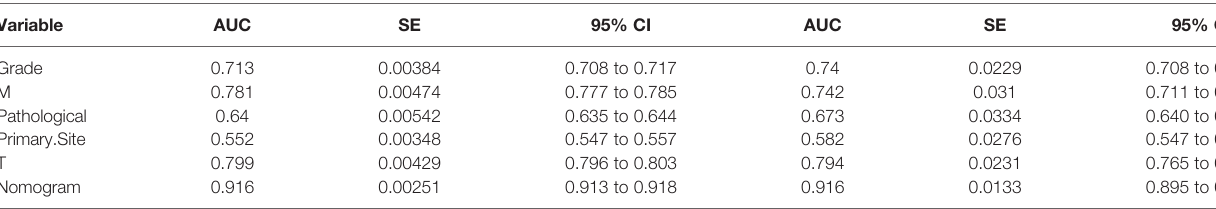
TABLE 4 | Area under the ROC Curve (AUC) of the training and veri fi cation groups. Variable